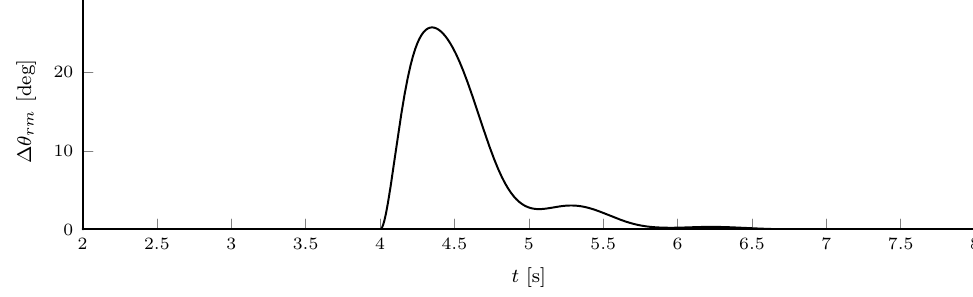
Figure 17. Normed angle difference; voltage-source